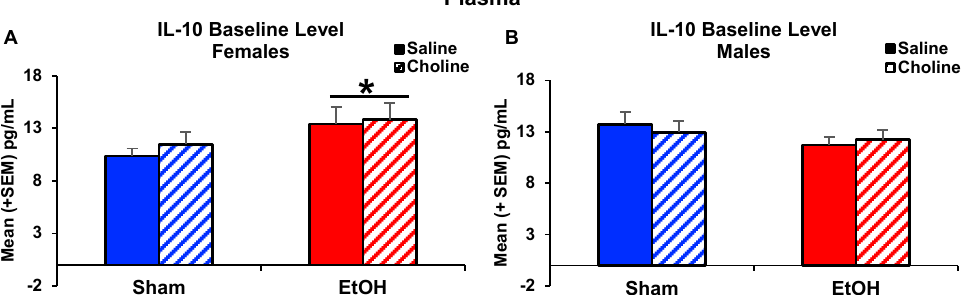
Figure 8. Sex differences in IL-10 plasma cytokines levels. Females exposed to ethanol during early development had lower baseline levels of IL-10. ( A ) Baseline IL-10 levels in females (EtOH > Sham, * p < 0.05). ( B ) Baseline IL-10 levels in males. n = 10–11 per group.